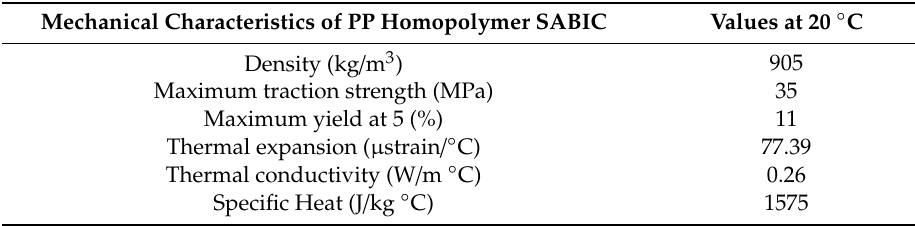
Table 3. Mechanical characteristics of PP Homopolymer SABIC PP